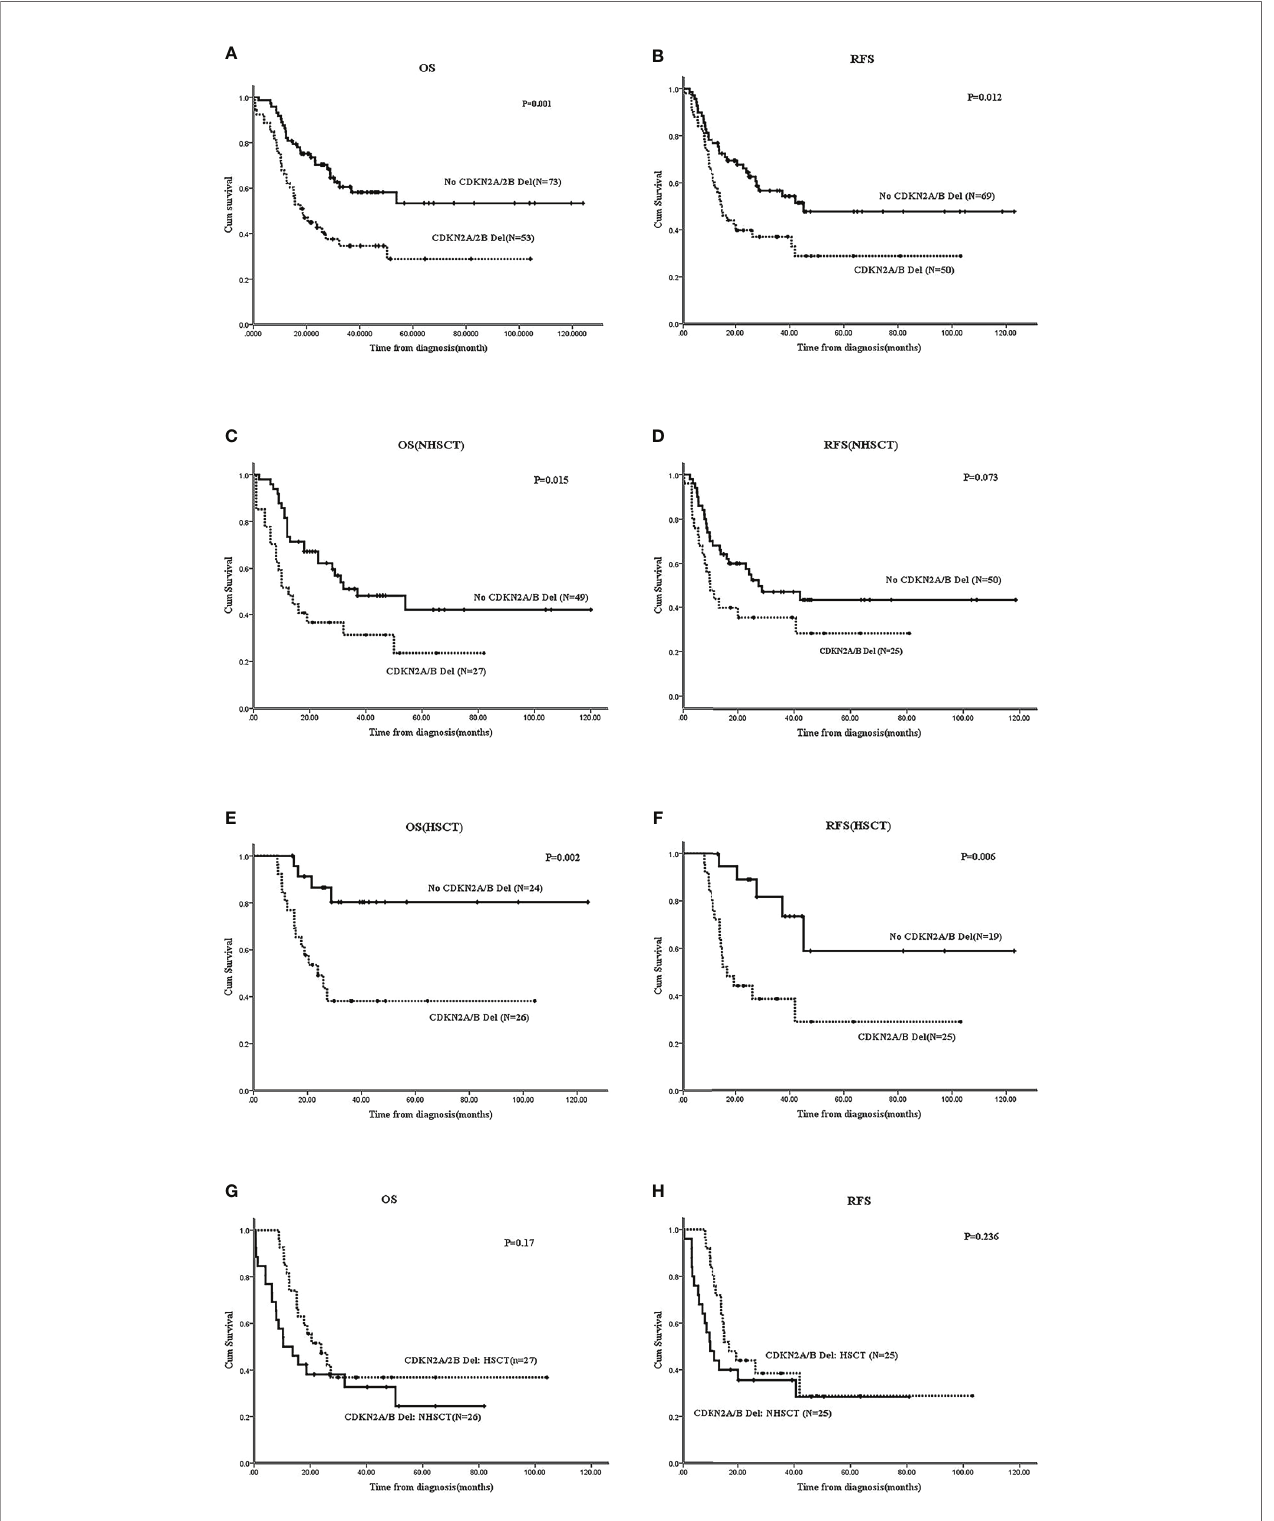
FIGURE 4 | Effect of CDKN2A/B deletion on survivals of Ph-B-ALL patients by Kaplan-Meier plots. (A, B) The 2-year OS and RFS of Ph-B-ALL patients who carried CDKN2A/B deletion vs. no CDKN2A/B deletion. (C, D) The 2-year OS and RFS of Ph-B-ALL patients who carried CDKN2A/B deletion vs. no CDKN2A/B deletion in no HSCT group. (E, F) The 2-year OS and RFS of Ph-B-ALL patients who carried CDKN2A/B deletion vs. no CDKN2A/B deletion in HSCT group. (G, H) The 2-year OS and RFS of Ph-B-ALL patients with CDKN2A/B deletion who received HSCT vs. no